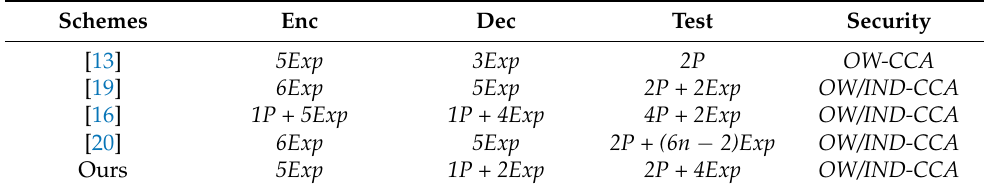
Table 1. Comparison of Computational